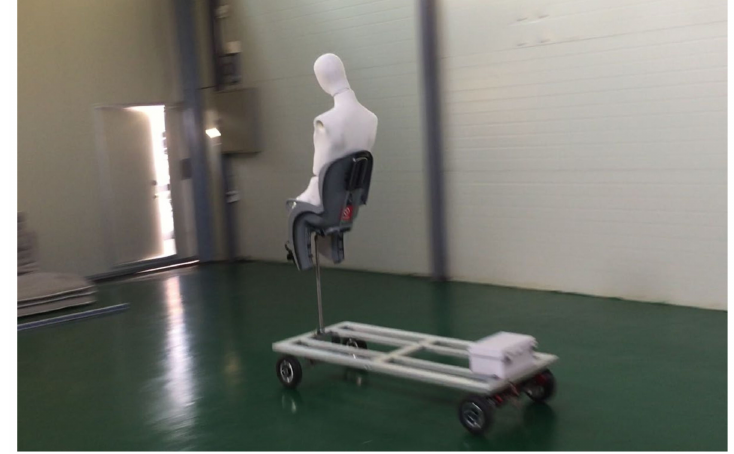
Figure 13. Motorcar with a mannequin for collision